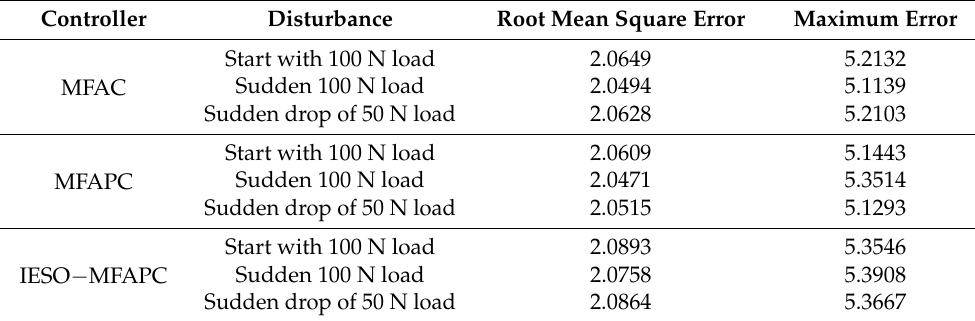
Figure 9. Thrust curve of a sudden load applied by the four control algorithms. Table 5. Thrust fluctuation quantity index of three control algorithms under load change.